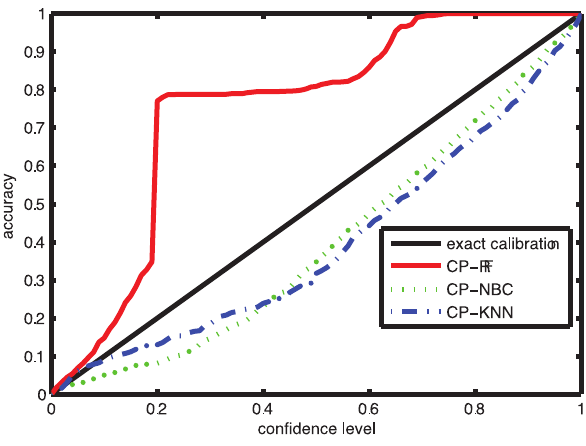
Figure 9. Calibration property of CPs on CF